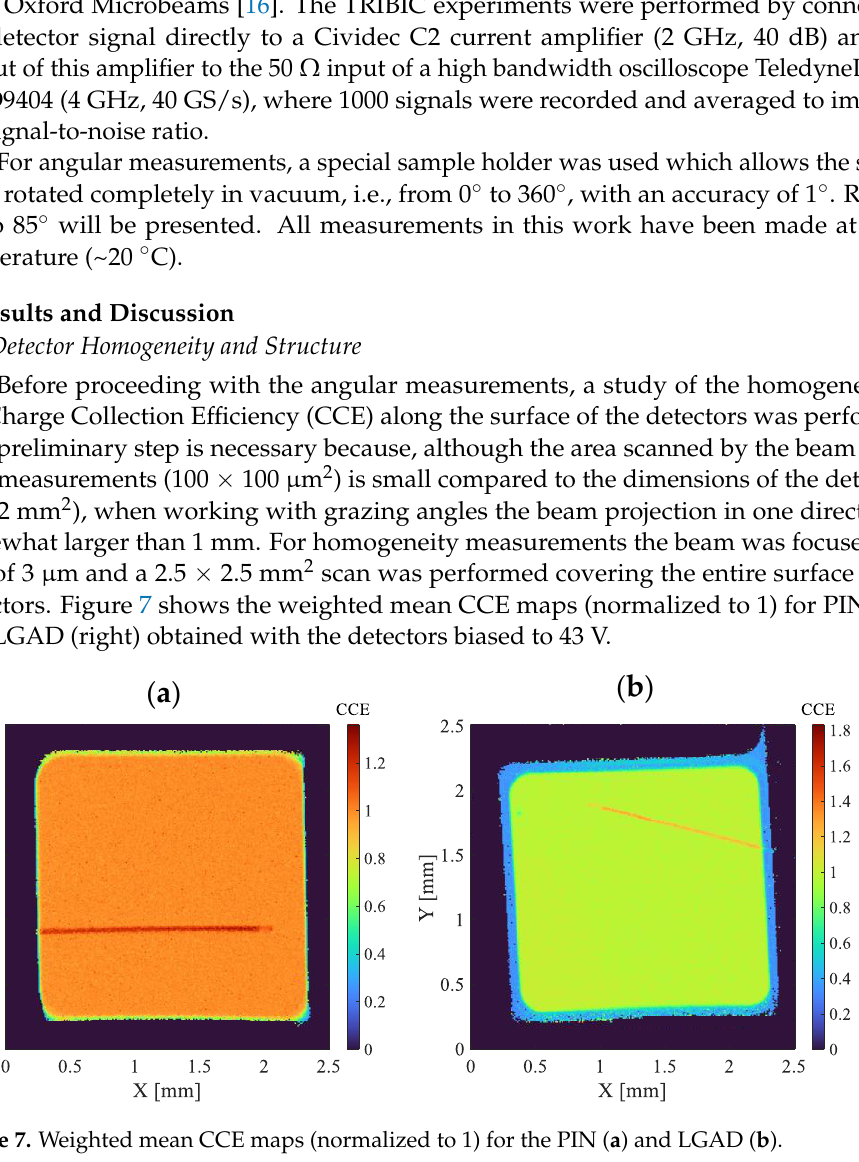
Figure 7. Weighted mean CCE maps (normalized to 1) for the PIN ( a ) and LGAD ( b ).